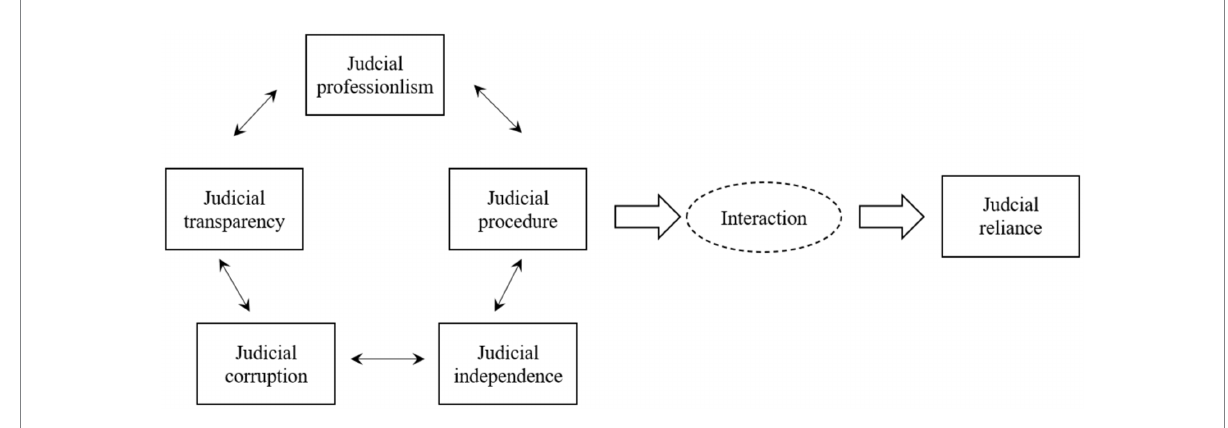
FIGURE 2 Theoretic framework: judicial conditions and judicial